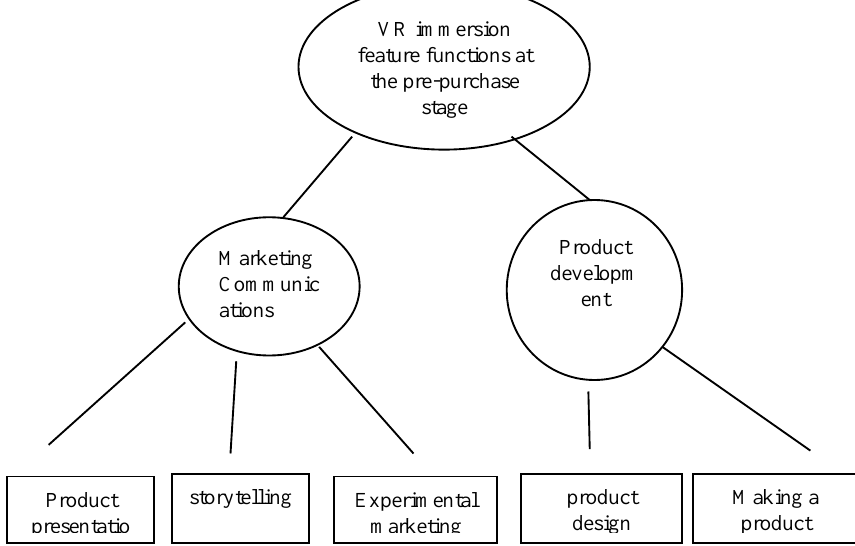
Figure 5 - VR immersion feature functions in the pre-purchase